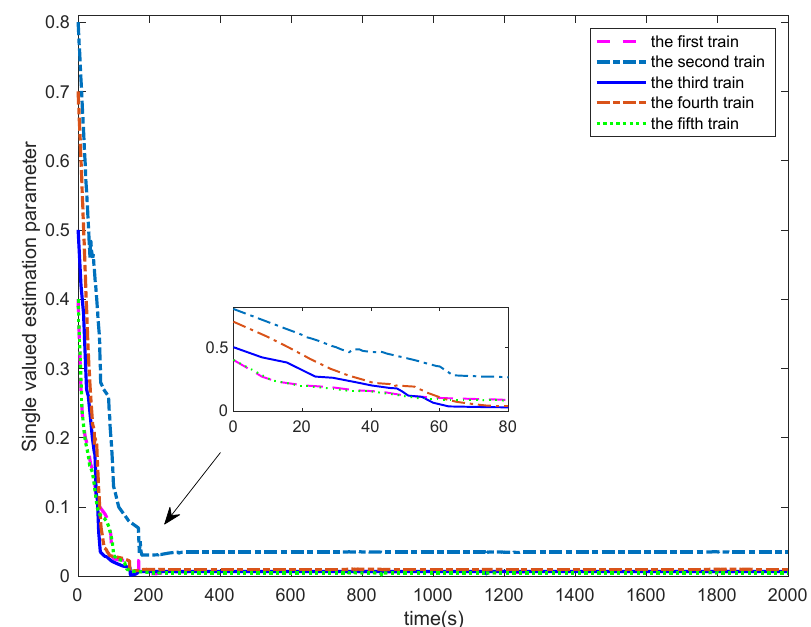
Figure 7. Estimated parameter curves for single-value learning.